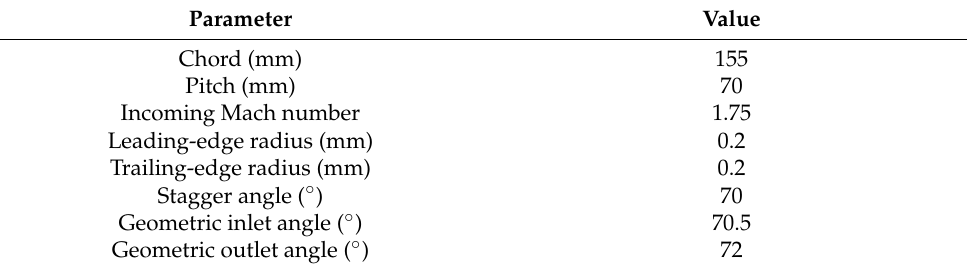
Table 1. Main parameters of the supersonic cascade